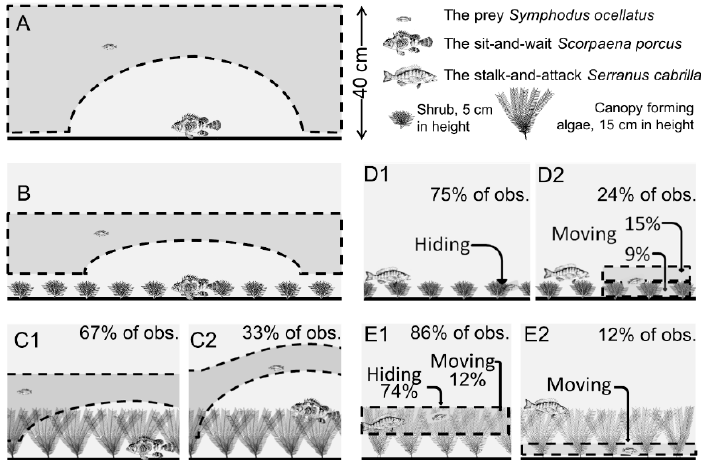
Figure 5. Schematic representations of the predator-specific anti-predator behavior of wrasse, depending on habitat types. Wrasse and scorpionfish behavioral interactions within bare control habitat ( A ), within shrub habitat ( B ) and within forest habitat (patterns C1 and C2 observed in 67% and 33% of cases respectively); wrasse and comber behavioral interactions within shrub habitat (patterns D1 and D2 observed in 75% and 25% of cases respectively) and within forest habitat (patterns E1 and E2 observed in 86% and 12% of case respectively). Formal tests of associations among categories of activity, prey and predator positions and predator–prey distances are reported in Supplementary File S1.